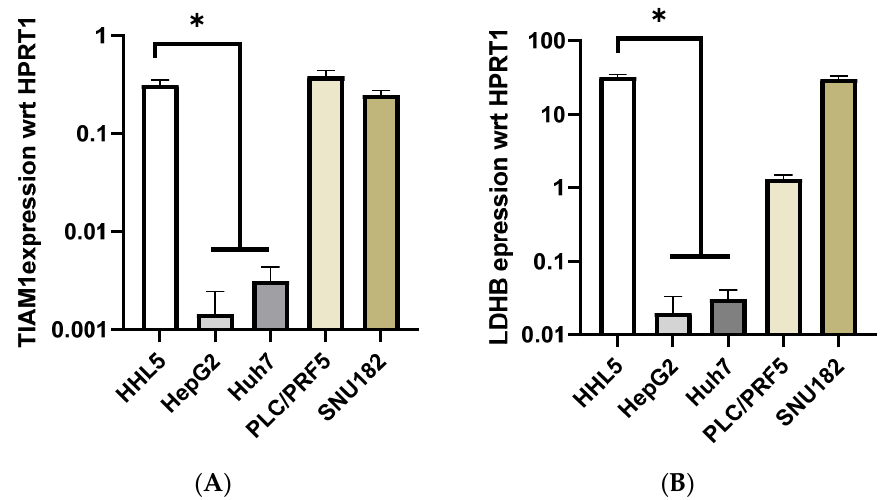
Figure 3. Relative TIAM1 and LDHB gene expression normalized with internal hypoxanthine phos- phoribosyl transferase (HPRT1) . ( A ) The relative TIAM1 expression compared with HPRT1 and ( B ) the relative LDHB expression compared with HPRT1 . Data are calculated as 2 − Δ Ct , and values are shown as mean ± SEM ( n = 4). Δ Ct is the Ct value of targeted TIAM1 or LDHB gene minus Ct value of the housekeeping gene ( HPRT1 ). * p < 0.0001, for one-way ANOVA with multiple comparisons using HHL5 as the base sample.